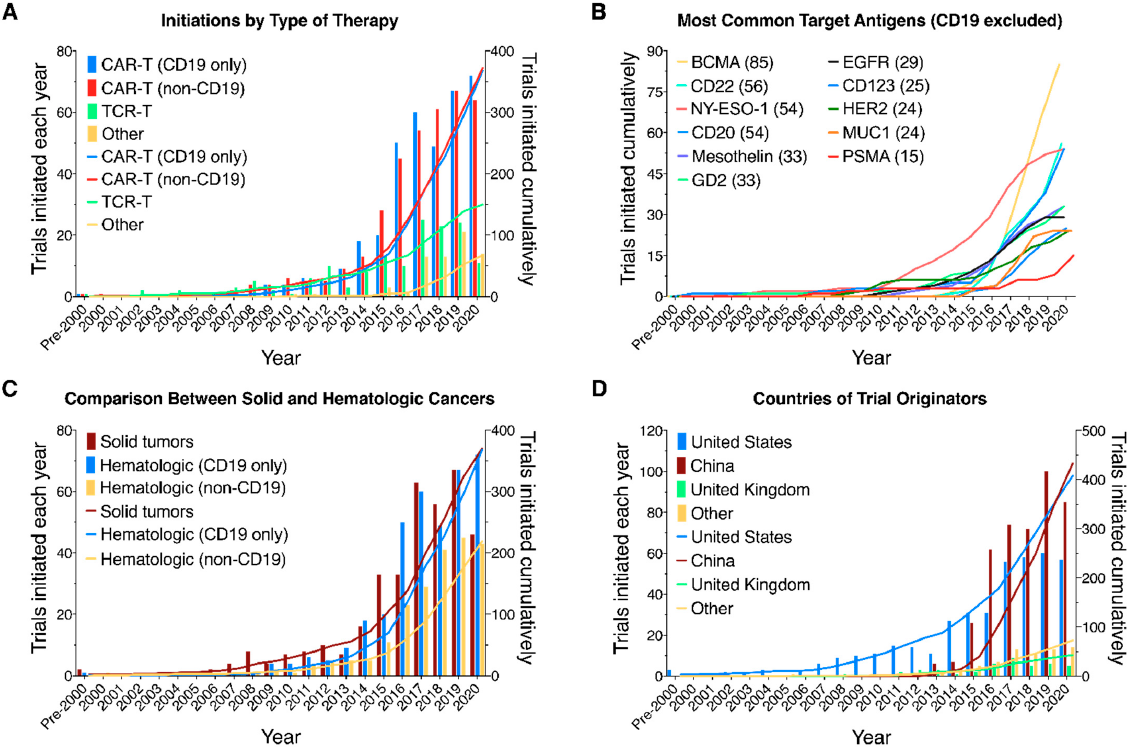
Figure 3. Comparison of different types of therapy, antigens, and tissue targeted, and countries of clinical trial originators. Yearly (bars) and cumulative (lines) numbers of CAR-T/TCR-T trials registered on clinicaltrials.gov and initiated on or before 31 December 2020. ( A ) Trials segmented by type of therapy. CAR-Ts are divided into those targeting CD19 (either alone or in combination with other antigens) and all other trials. ( B ) Number of clinical trials for the 11 most frequently targeted antigens other than CD19. ( C ) Comparison of clinical trials targeting solid tumors and hematologic cancers. Hematologic cancer trials are divided into those targeting CD19 (either alone or in combination with other antigens) and all other trials. ( D ) Number of clinical trials by originators from China, United States, United Kingdom, and other